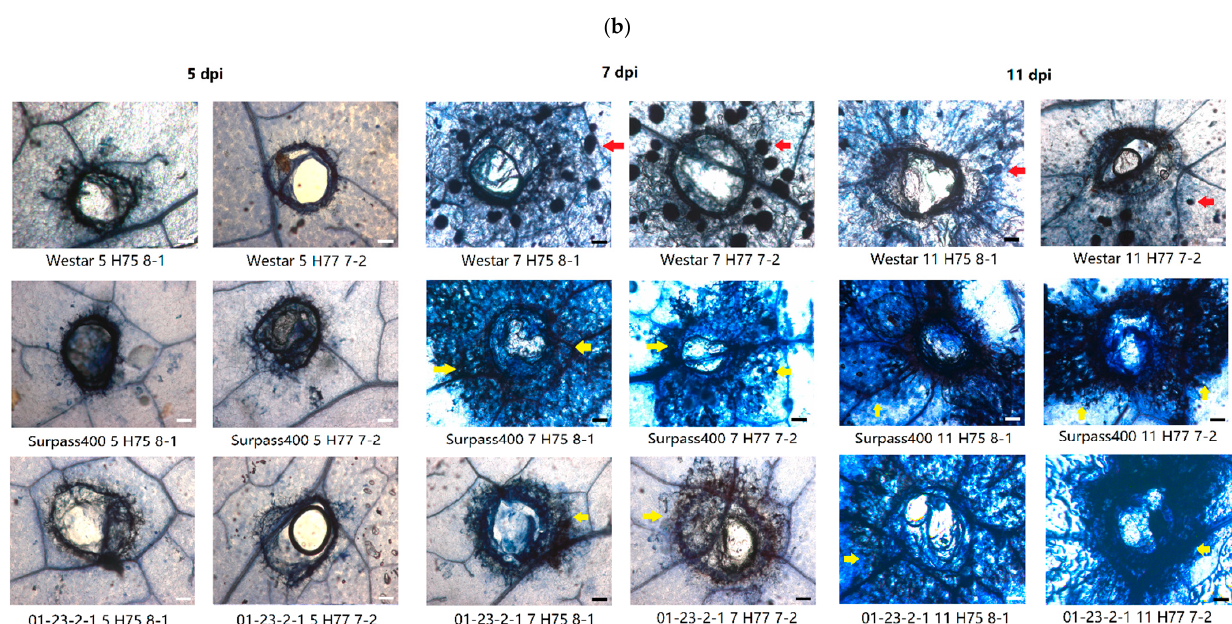
Figure 3. Regions of cell death (stained with trypan blue) at 5, 7, and 11 dpi adjacent to the origin of fungal development from 6 inoculation pairs (genotype/isolate: Westar-H75 8-1/H77 7-2, Surpass400 – H75 8-1/H77 7-2 and 01-23-2-1 – H75 8-1/H77 7-2). ( a ) The scanned cotyledons stained with trypan blue (representative images) showed the spread of cell death (dark blue) throughout the cotyledons initiated from the sites of inoculation (center of each lobe). The potential regions of cell death on the cotyledons were highlighted by black arrows. ( b ) The representative microscopic images (magnitude: 50×) taken around the sites of inoculation, the formations of senescent cells (yellow arrows), hyphal development (red arrows), and pycnidia (red arrows) formations were visualized under the microscope. Bars (black and white) = 100 µm.